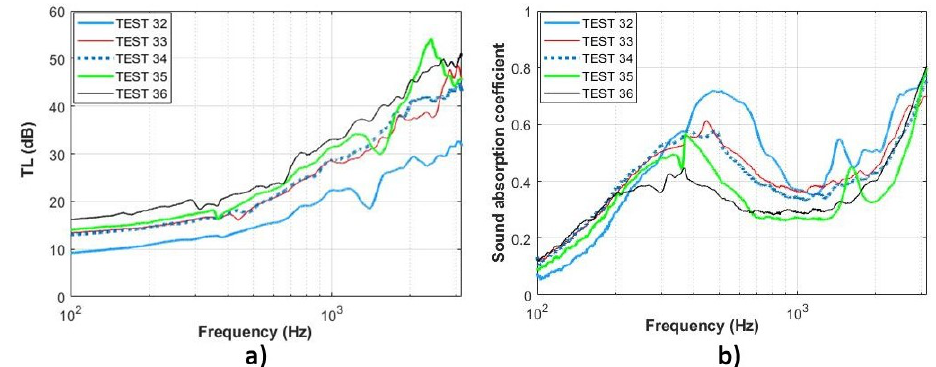
Figure 13. Transmission loss ( a ) and absorption coefficient ( b ) of samples made of egg-boxes and